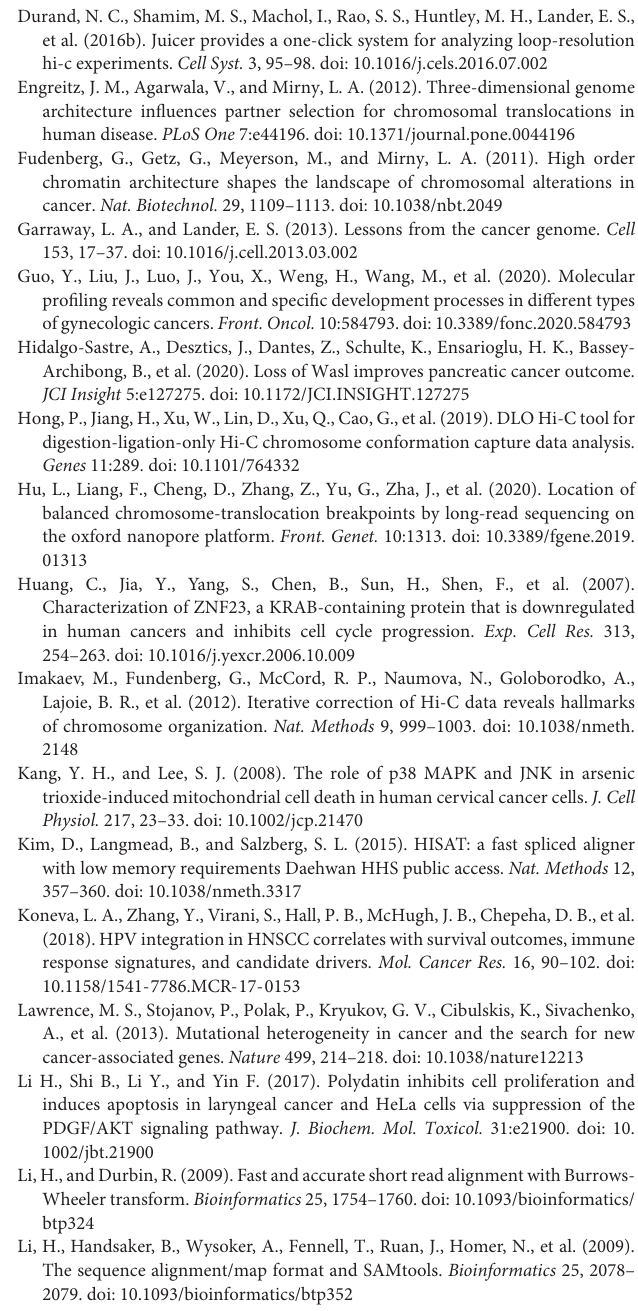
self-ligated and non-ligated pairs, valid reads, intra–inter chromosomal interactions, and long- and short-range chromatin interactions. Supplementary Table 4 | Translocations detected by hic_breakfinder. Translocations detected by hic_breakfinder in cervical cancer samples, the table showing the translocation boundaries along with the strand information. Supplementary Table 5 | Translocations identified by HiC_Trans. Translocations detected by HiC_Trans in cervical cancer samples, the table showing the breakpoint boundaries along with the z-score.